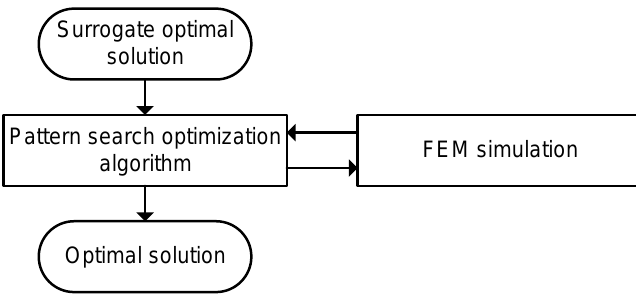
Figure 7. Flow chart: proposed optimization routine—part 2 (pattern